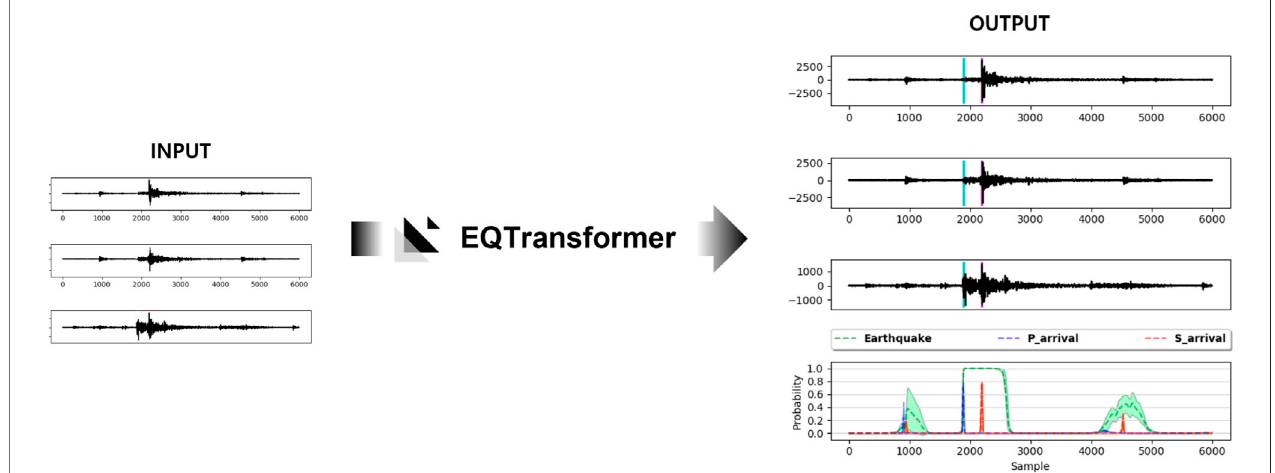
FIGURE 1 | EQTransformer to input signals, detect earthquakes in earthquake waveforms, mark P/S wave arrivals, and output their probabilistic statistics. There arefourplotsintheoutput.Lightbluelinesindicatetheearthquakelocationsinthethreeupperplots.Inthelastoutputplot,agreendottedlineindicatestheprobabilityof an earthquake, a blue dotted line indicates the probability for the starting point of the P wave, and a red dotted line indicates the probability for the starting point of the S